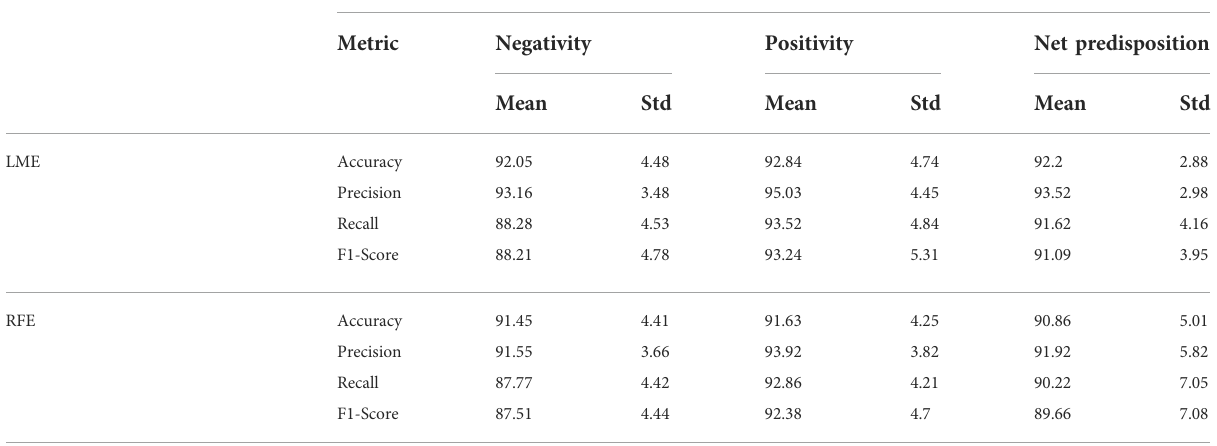
TABLE1Meanaccuracy,precision,recallandF1-scoreobtainedforeachaffectivedimensionoftheESM(Cacioppoetal.,1997).Valueswereobtained with a 12-fold cross-validation (see Section 3.4). Means were obtained in three steps. First, values were averaged across folds. Then, values were averaged across iterations (10 iterations per participant). Finally, means and standard deviation were calculated across participants. Feature selection